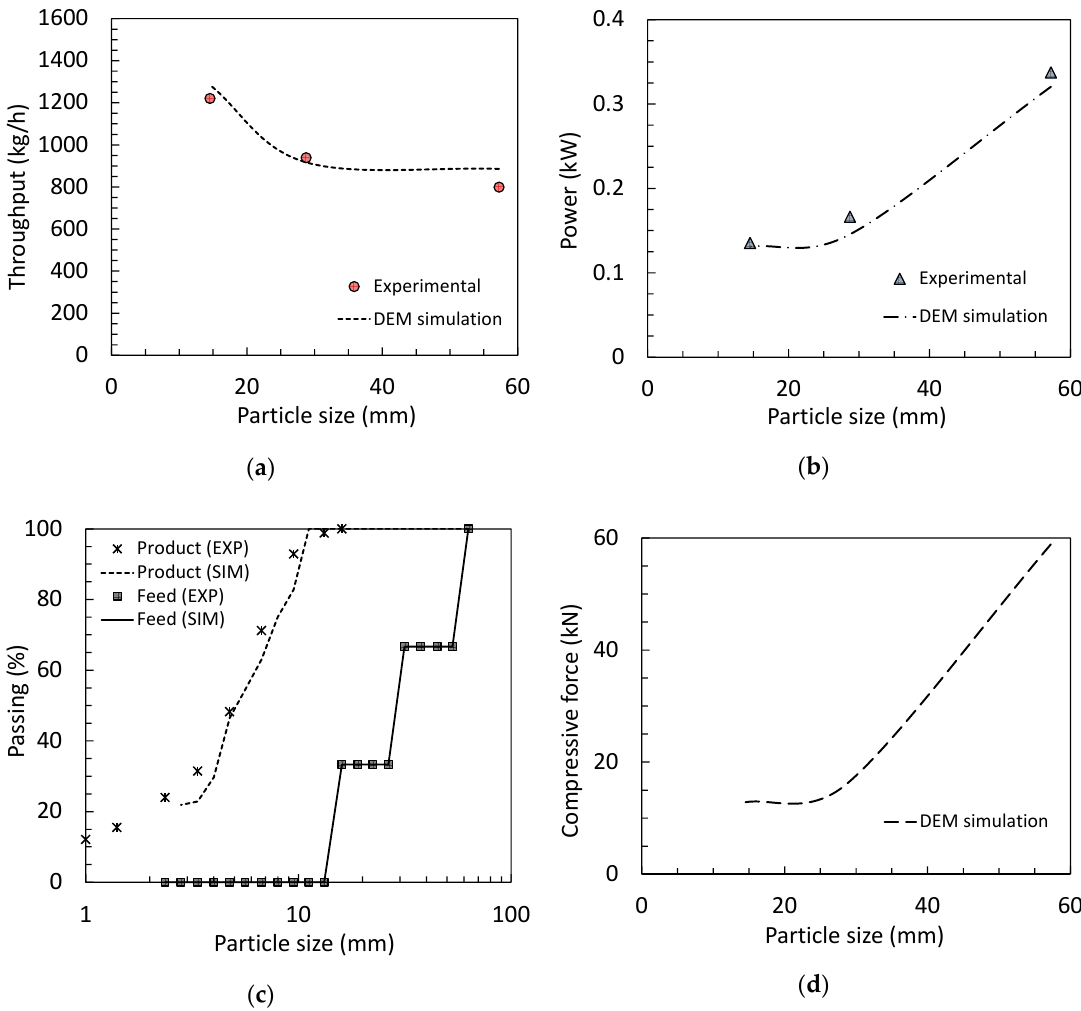
Figure 14. Comparison between experiments and DEM simulations for the jaw crusher throughput ( a ), power ( b ) and product size distribution ( c ); simulated trend on the compressive force ( d ). Figures a, b and d presented as a function of mean feed particle size.